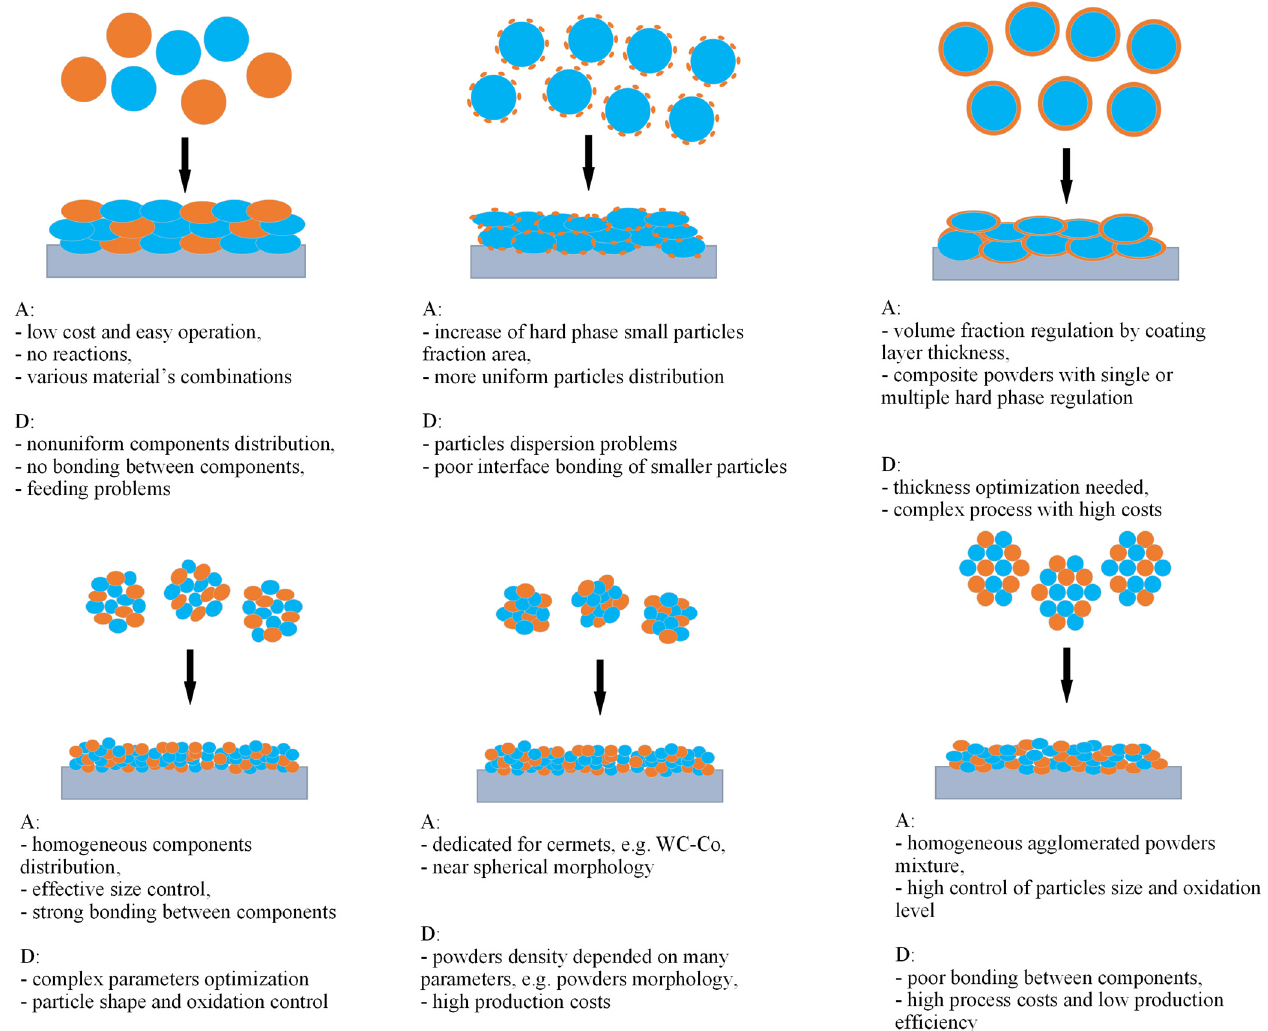
Figure 5. Comparison of different powder preparation methods and schematic deposition onto the substrate: mechanical blend ( upper left ), satelliting ( upper middle ), powder cladding ( upper right ), mechanical ball milling ( lower left ), ball milling with SHS or annealing ( lower middle ) and spray drying ( lower right ). Blue and orange colours mean various phases. A—advantage, D—disadvantage (inspired by [98]).